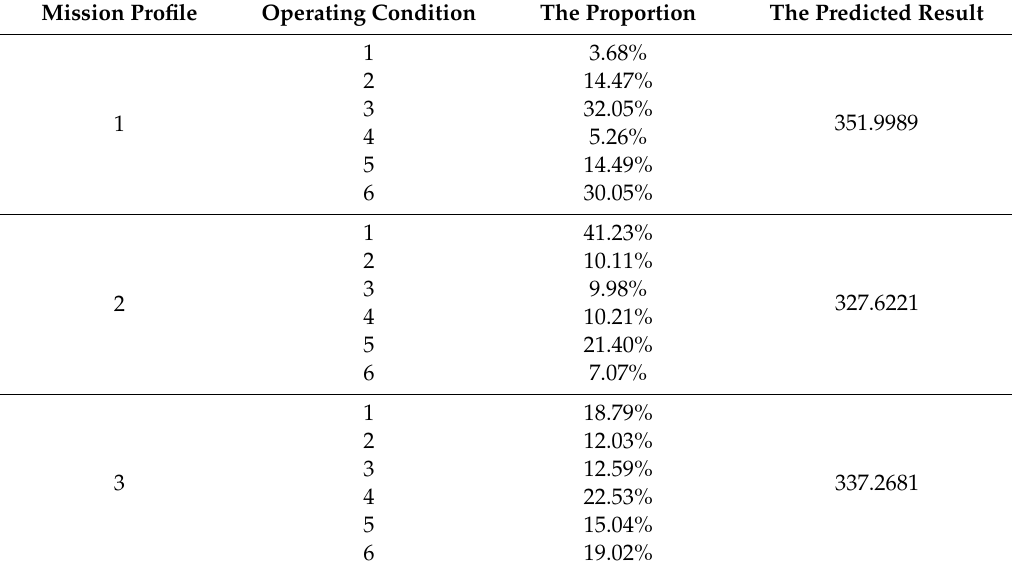
Table 7. The predicted result under di ff erent mission profiles when mission profile